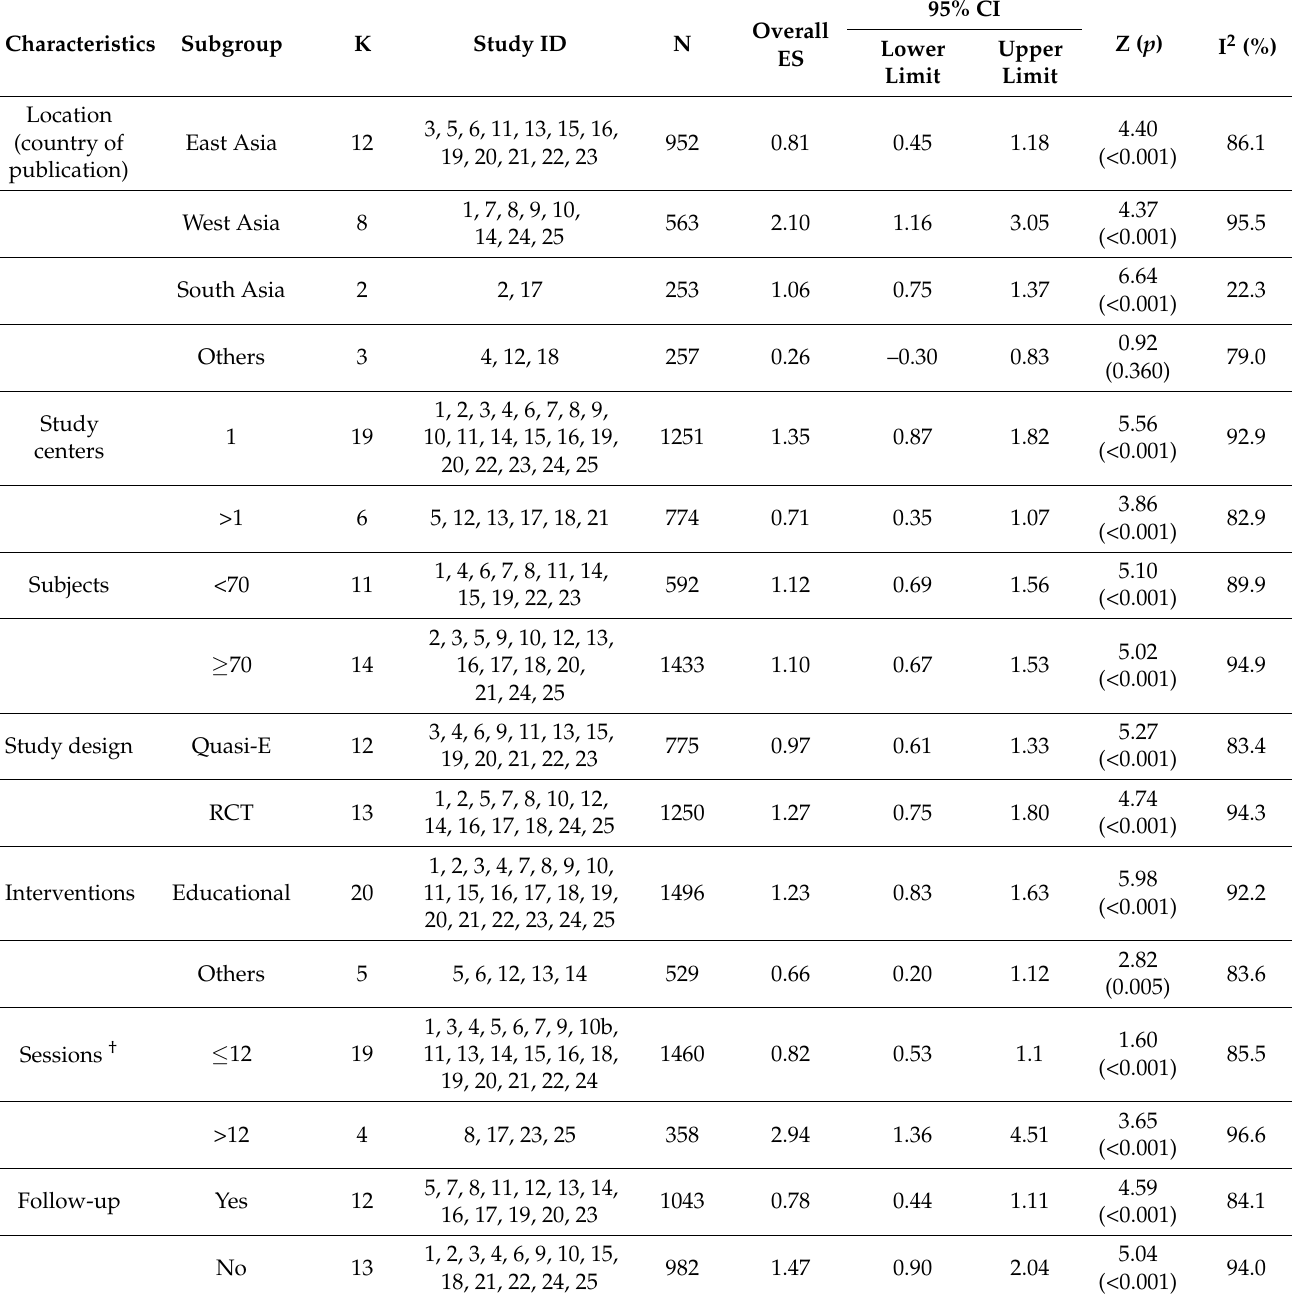
Table 4. Subgroup analysis regarding treatment adherence by study